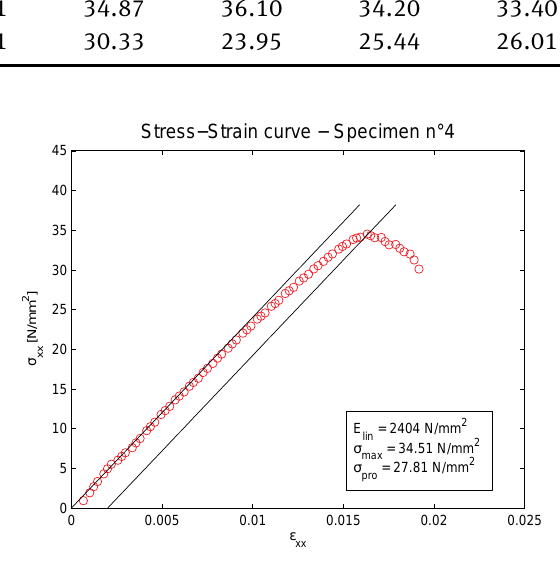
Figure 14: Actual stress-strain curve for specimen 4.